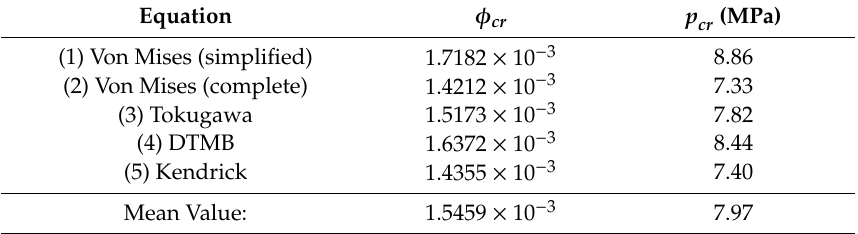
Table 1. Calculated critical pressures for the unsti ff ened shell using analytical formulations.